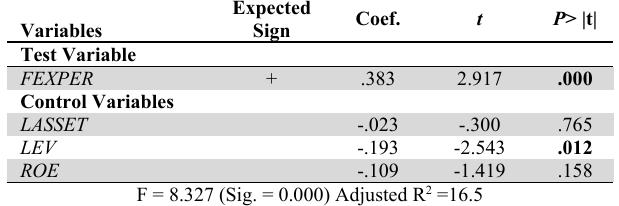
Multicollinearity statistics of assessing VIF and Tolerance Audit committee meeting frequency regression